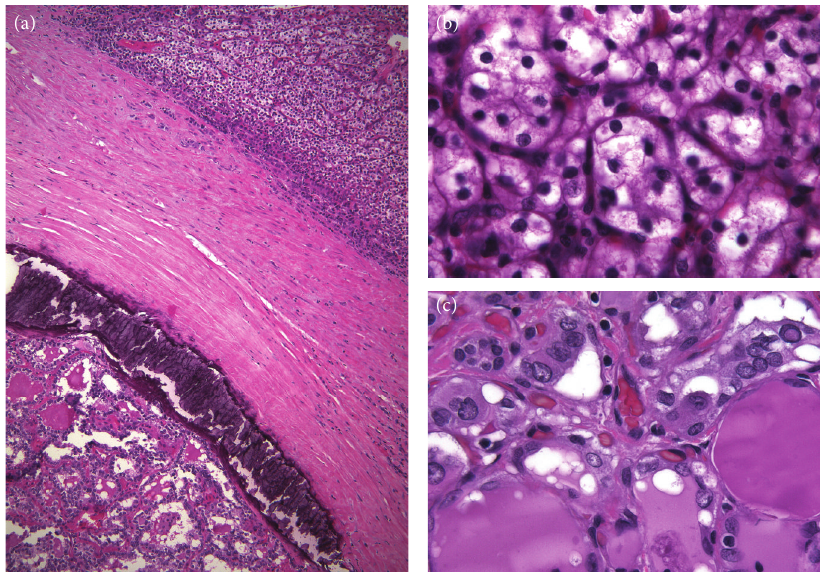
Figure 2: Concurrent renal cell carcinoma and thyroid carcinoma. (a) Thyroidectomy specimen showed synchronous foci of metastatic clear cellrenalcellcarcinoma(top)andpapillarythyroidcarcinoma(bottom)(hematoxylinandeosin).Thecharacteristicclearcellcytoplasmofthe renal cell carcinoma (b) and the peculiar nuclear features of papillary thyroid carcinoma (c) are seen at a higher magnification (hematoxylin and